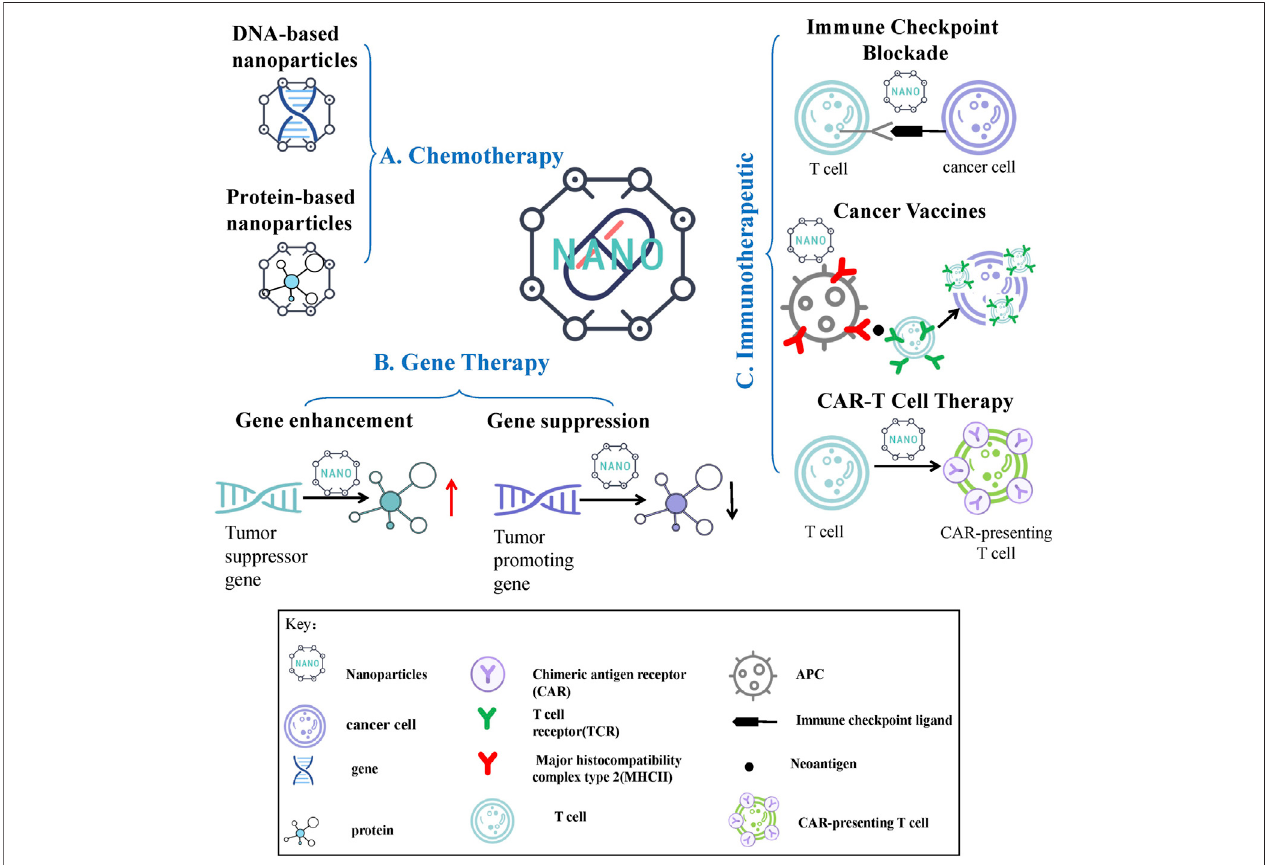
FIGURE 1 | Nanomedicine Delivery Strategies for Chemotherapy, Cancer Gene Therapy and Immunotherapy. (A) Chemotherapy nanomedicine: DNA-based nanoparticlesand protein-based nanoparticlesareshown inthisarticle. (B) Genetherapynanomedicine:geneenhancement therapyand genesuppression therapyare shown in this article. (C) Immunotherapeutic nanomedicine: immune checkpoint blockade therapy, cancer vaccines and chimeric antigen receptor T cell therapy are shown in this article.